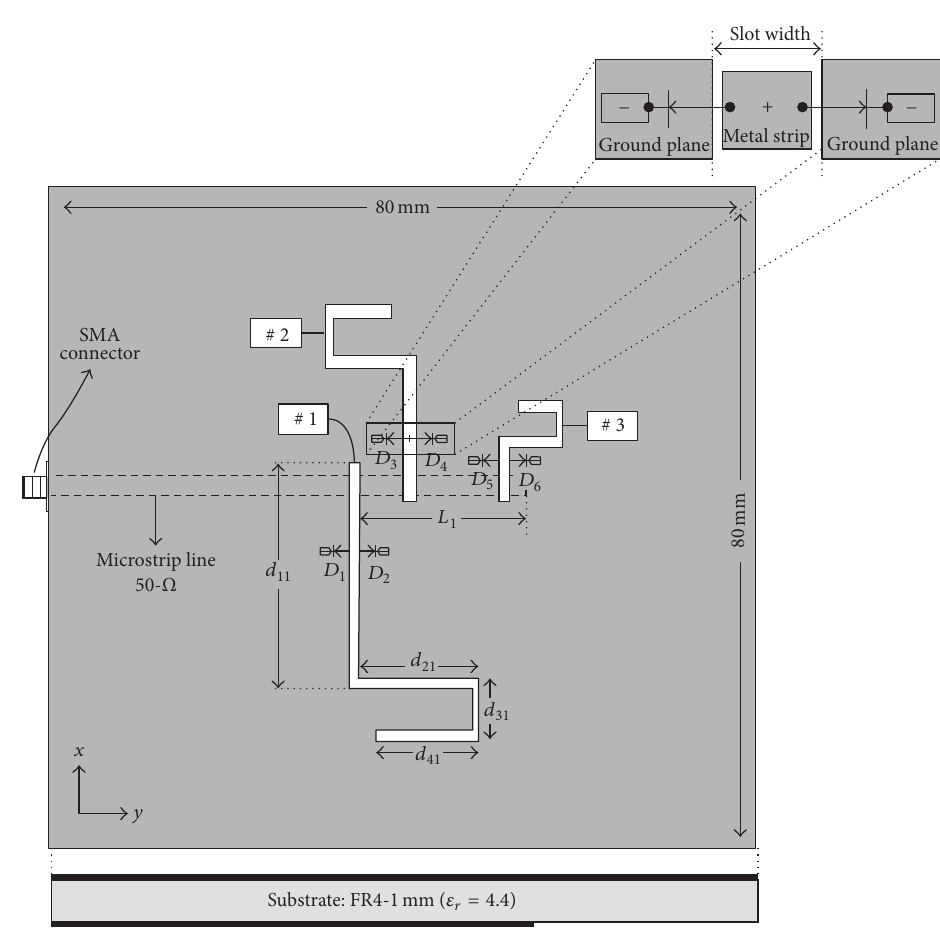
Figure 27: Configuration of the multifrequency triple-slot antenna [78].